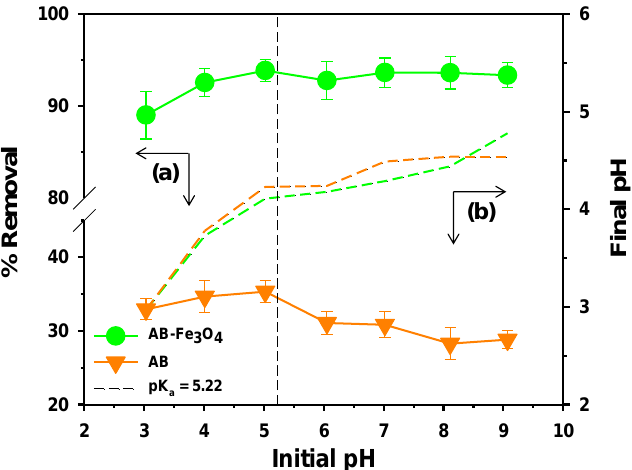
Figure 7. ( a ) E ff ect of solution pH on the uptake of TeCP by AB and AB-Fe 3 O 4 ( C 0 = 5 mg / L, V = 30 mL, adsorbent mass 30 mg, agitation speed = 300 rpm, temperature = 25 ± 1 ◦ C, and reaction time = 120 min); and ( b ) the final pH of the